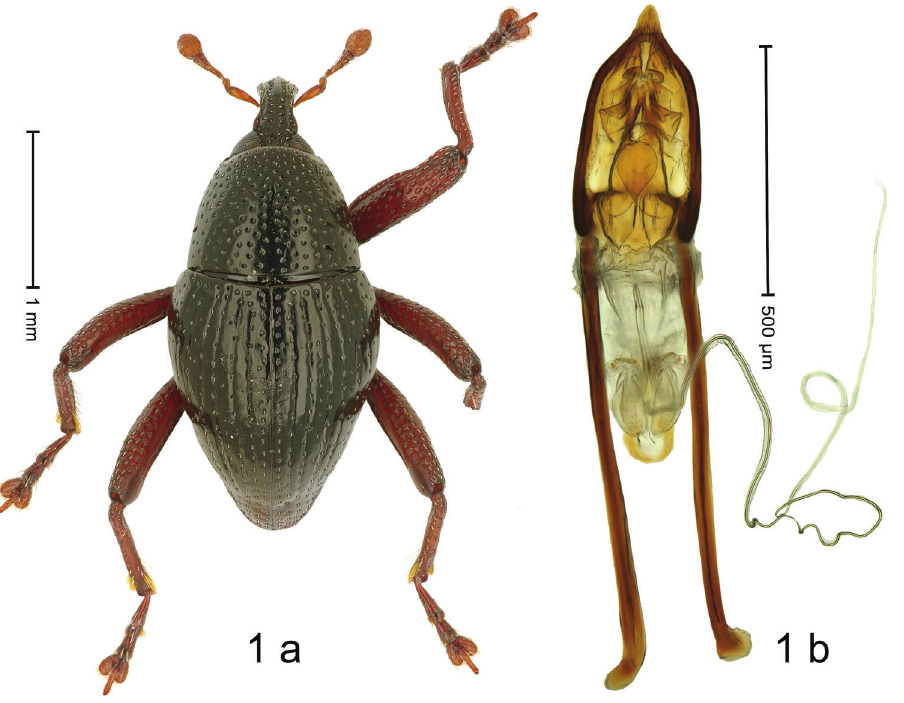
Figure 1. Trigonopterus acutus sp. nov., holotype a habitus b